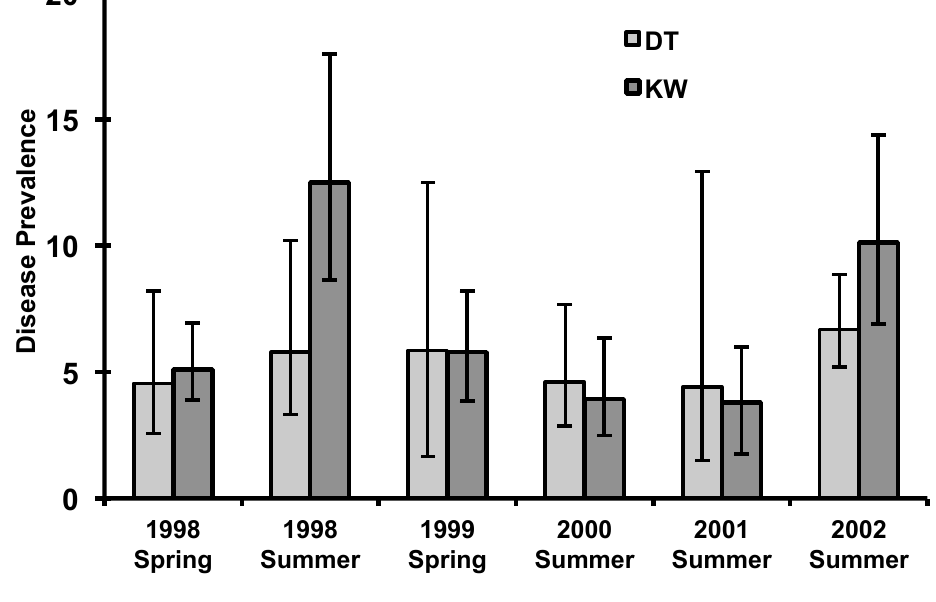
Figure 3. Mean coral disease prevalence (percent of colonies affected by one or more diseases) on Dry Tortugas (DT) and Key West (KW) reefs for 1998 to 2002 survey